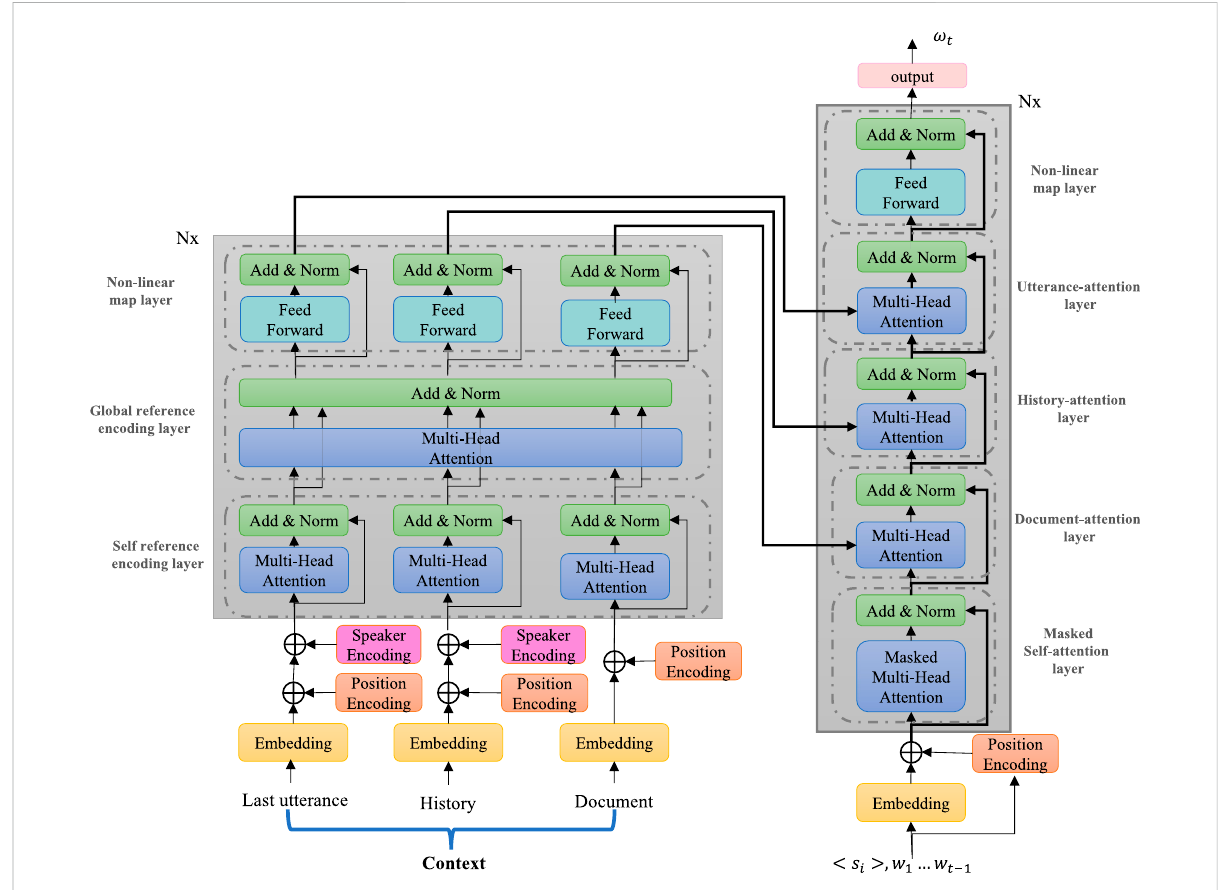
FIGURE 1 Framework of the model. The left is the context encoder with the triple channel. The right is the decoder interacted with contextual encoding for response